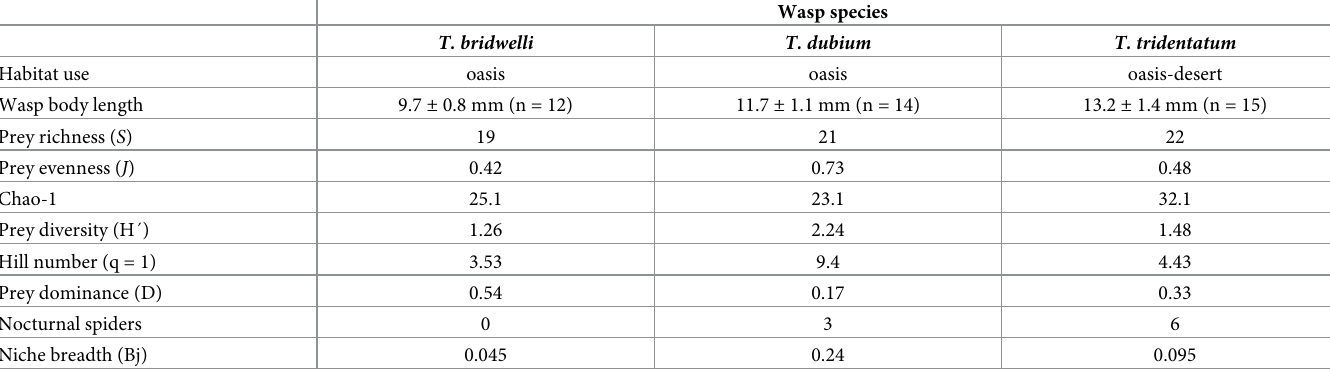
Table 3. Summary of diversity and functional parameters between the three wasp species and their prey. The habitat indicates where the nests of each wasp species were found. The wasp body length is the measurement from the frons to the last segment of metasoma (only females). All estimators and diversity indices were calculated for the total number of spider species each wasp